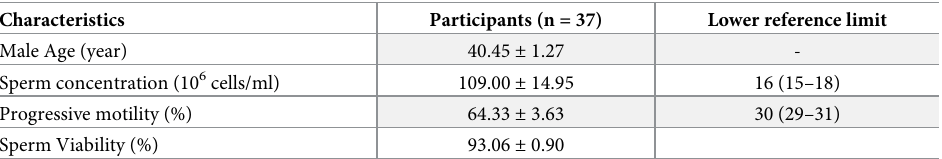
Table 1. Characteristics of semen